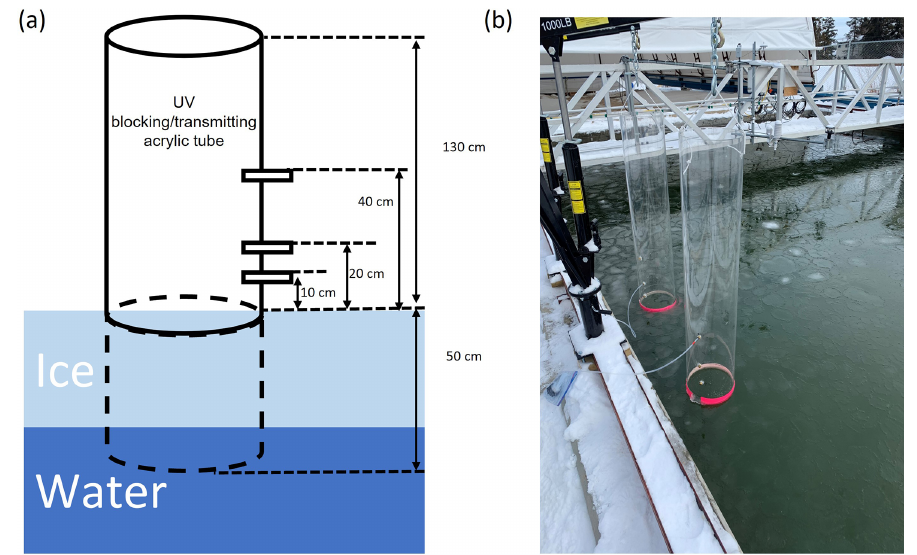
Figure 2. (a) An illustration and (b) a photo showing the experimental set-up at the Sea-ice Environmental Research Facility, Winnipeg, Canada. Two acrylic tubes (one UV-blocking and the other UV-transmitting) were fixed vertically in the sea ice pool, with gas measurement ports drilled at various heights through the tube